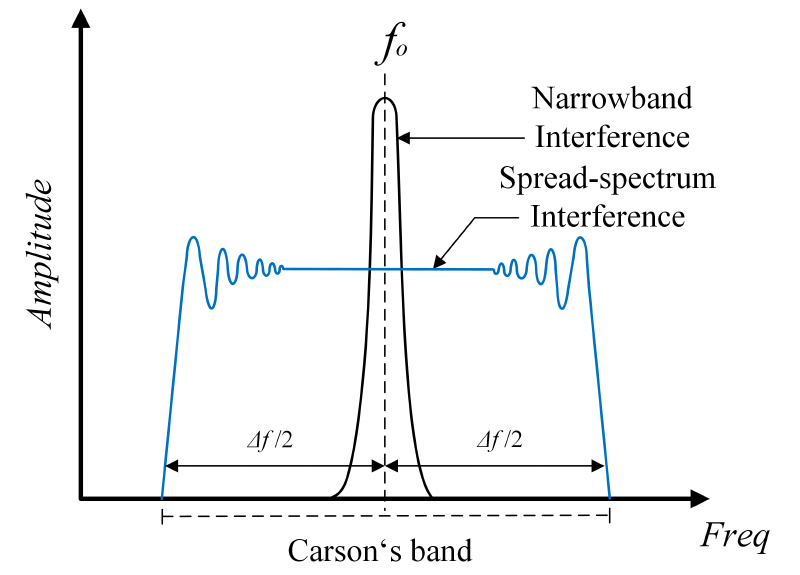
Figure 1. Conventional PWM vs. SSM